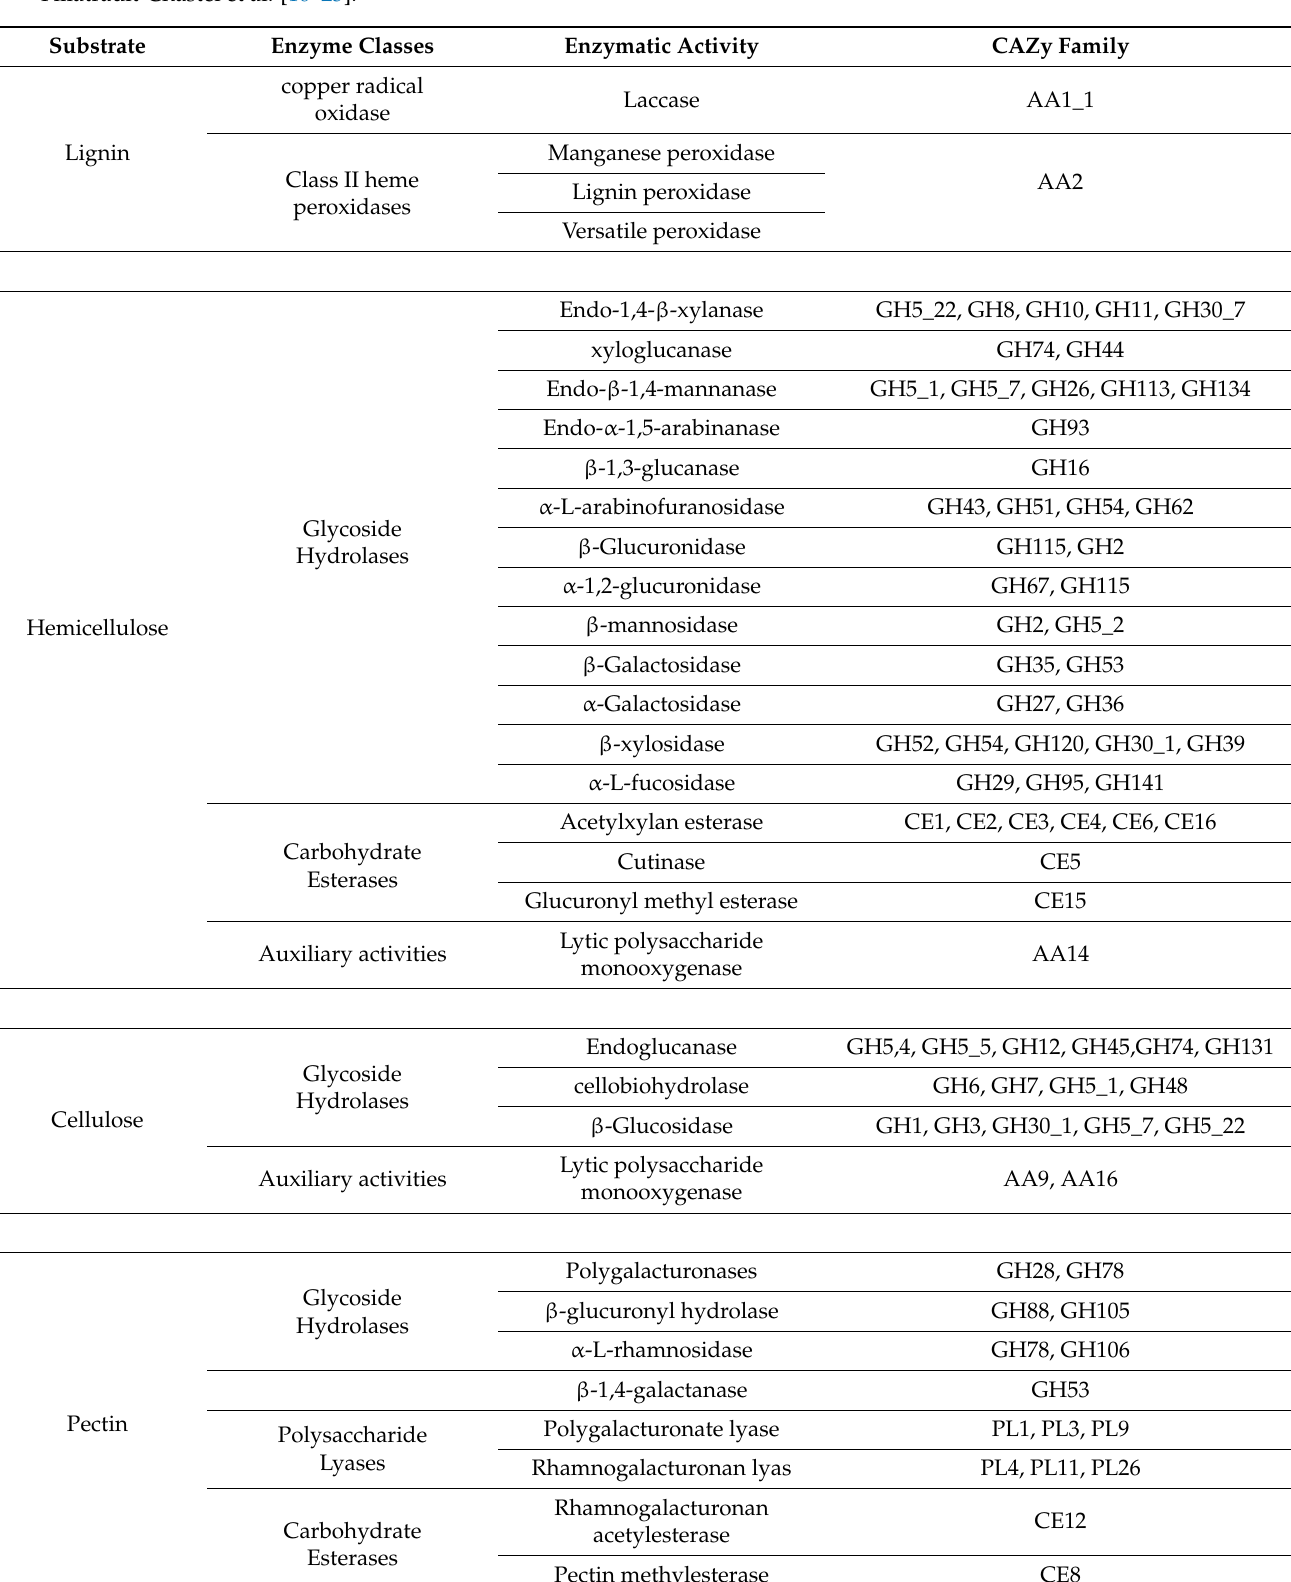
Table 1. Fungal carbohydrate-active enzymes (CAZymes) active on plant-cell walls. Activities were reported in Hen- riksson et al., Cantarel et al., Gruber and Seidl-Seibothl, Floudas et al., Sipos et al., Couturier et al., Andlar et al., and Filiatrault-Chastel et al.